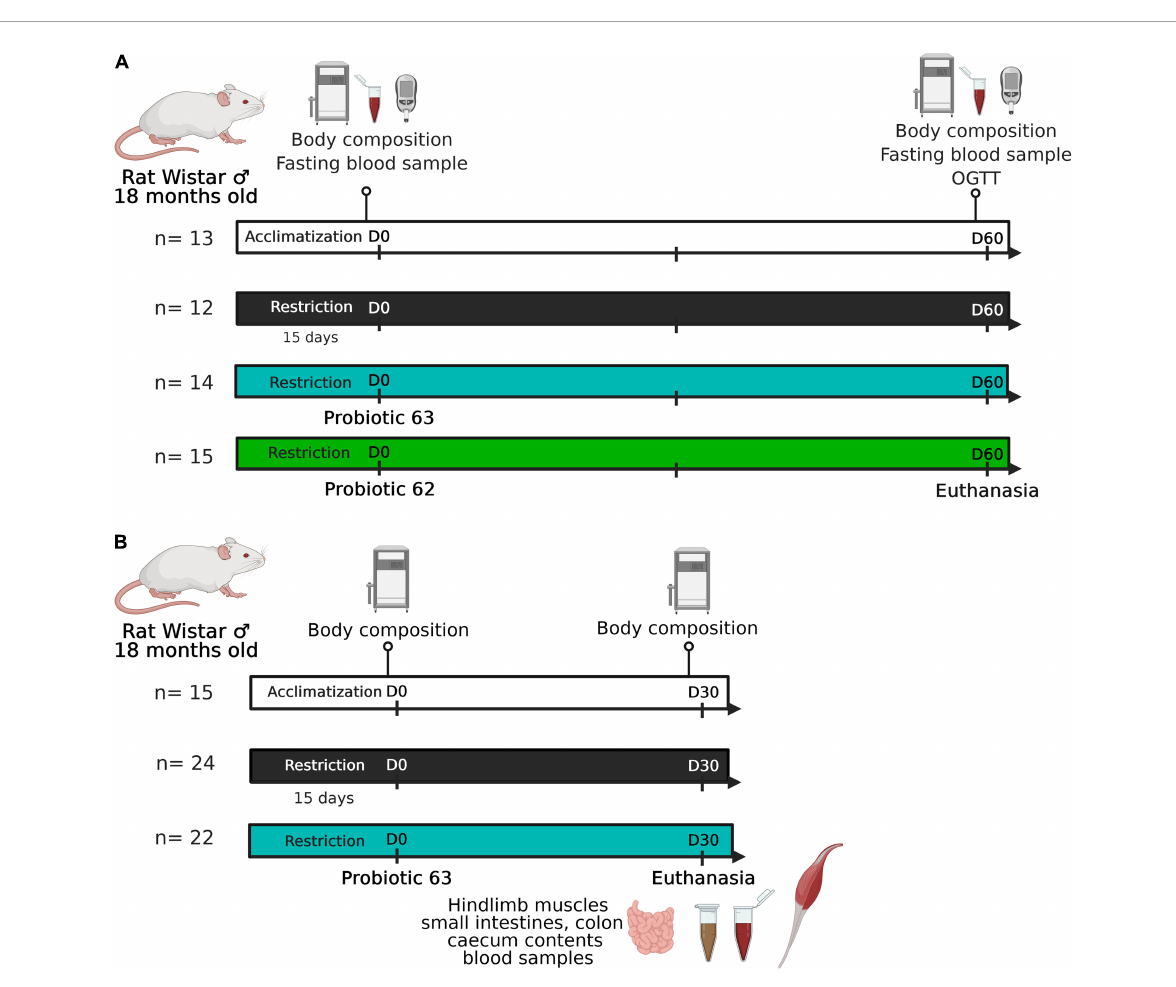
FIGURE1 Experimental design. (A) Experiment #1: 18-month-old Wistar rats ( n = 41) experienced a food-restricted diet (75% of ad libitum consumption). Starting on day 0, two groups of rats ( n = 29) began receiving a probiotic supplement (strain 62 or 63; 10 9 CFU/day). Rat body composition and glucose tolerance were characterized at the beginning (day 0) and end (day 60) of the experiment. (B) Experiment #2: 18-month-old Wistar rats ( n = 46) experienced a food-restricted diet (75% of ad libitum consumption). Starting on day 0, half of the food-restricted animals received strain 63 as a probiotic supplement (10 9 CFU/day). Rat body composition was characterized at the beginning (day 0) and end (day 30) of the experiment. The rodents were then euthanized after one last meal, and tissue samples were taken (i.e., hindlimb muscles, ileum, colon, cecal contents, and